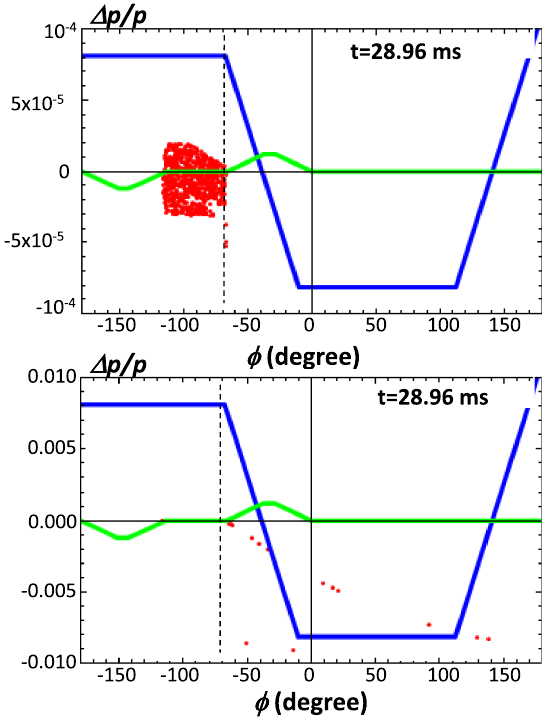
FIG. 12. More fine structure of the phase-space plot.